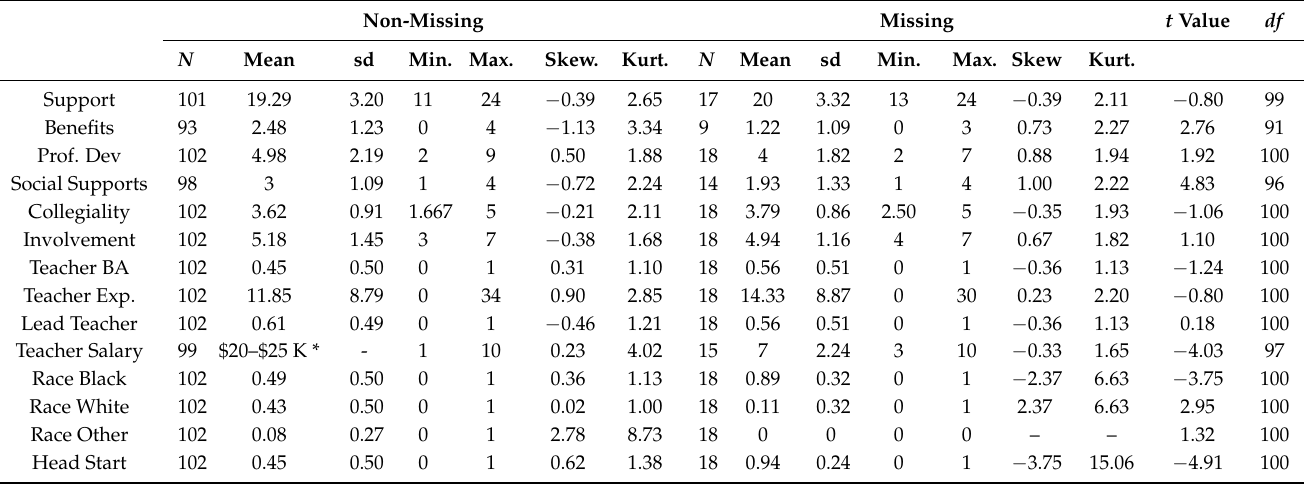
Table 2. Descriptive statistics and comparison of missing and non-missing